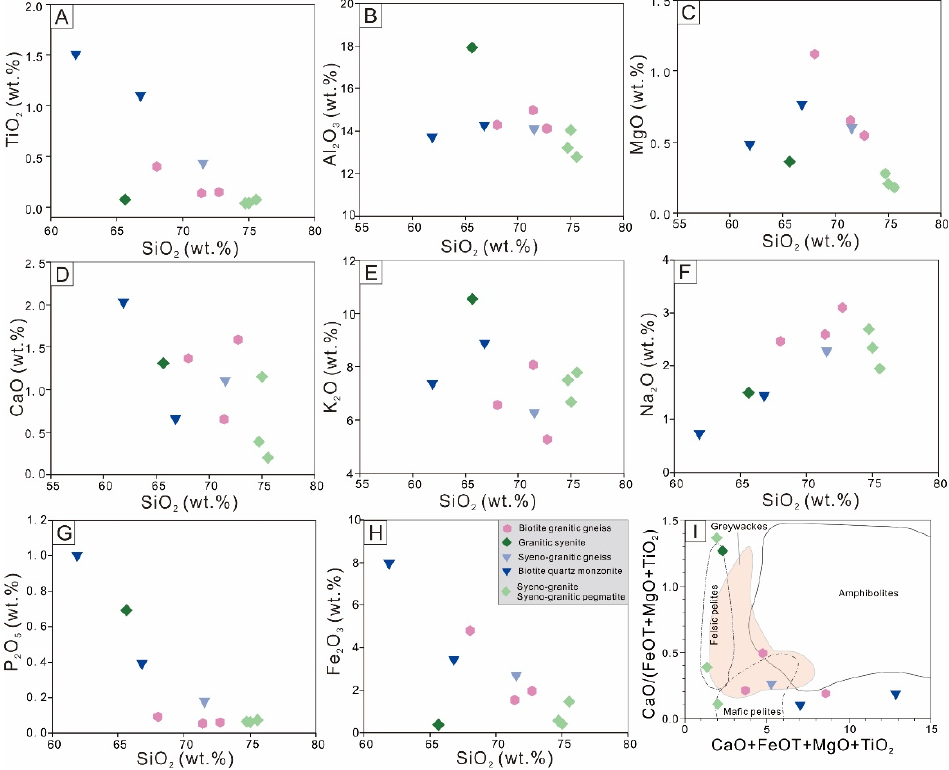
Figure 8. ( A – H ) SiO 2 vs. selected major elements showing variation trends of biotite granitic gneiss, syeno-granite, syeno-granitic pegmatite, granitic syenite, syeno-granitic gneiss, and botite quartz monzonite. ( I ) CaO/(FeO T + MgO + TiO 2 )-CaO + FeO T + MgO + TiO 2 diagram for discriminating melt sources from amphibolites, greywackes, mafic/felsic pelites [49]. The granitic gneiss and syeno-granitic rocks, granitic syenite and biotite quartz monazite, are characterized by negative Eu, Sr, and Ba anomalies, which indicate plagio-